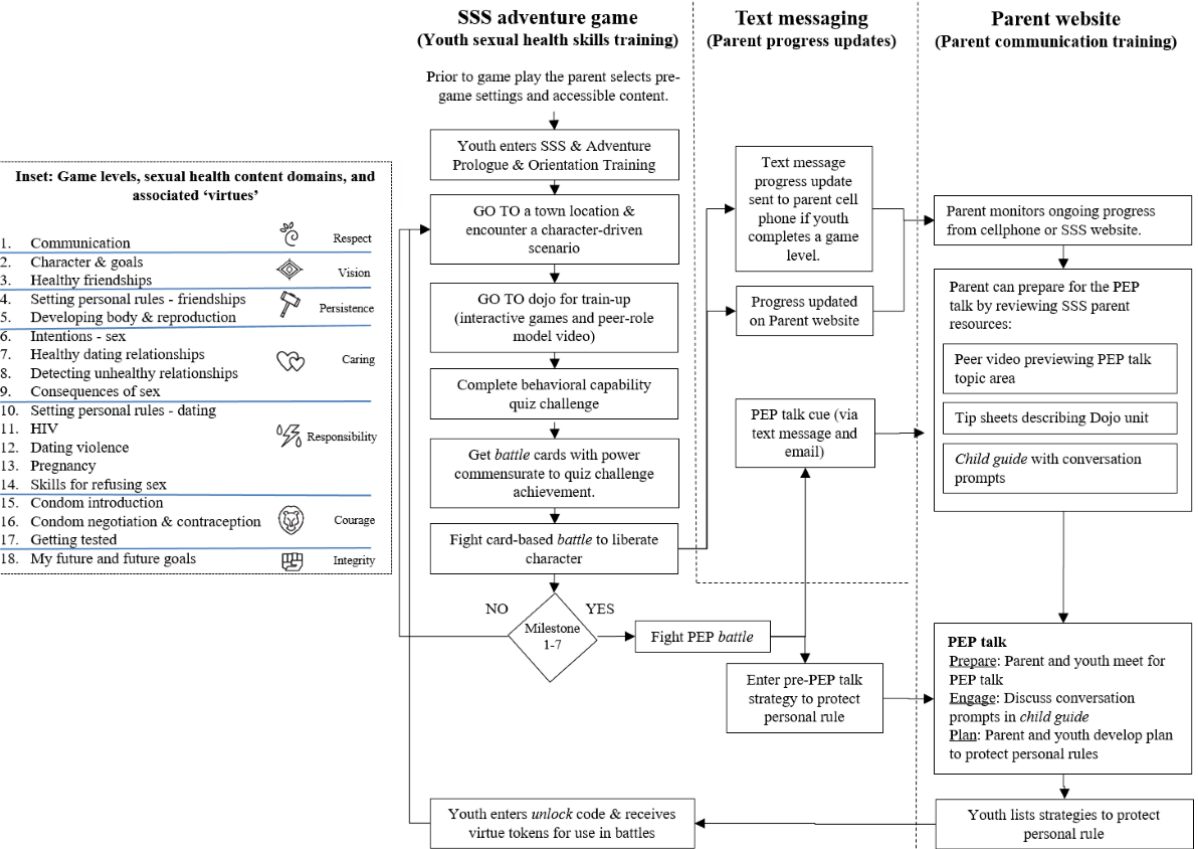
Figure 2. The Secret of Seven Stones program scope and sequence of play and content domains (inset). PEP: partner-engage-plan; SSS: the Secret of Seven